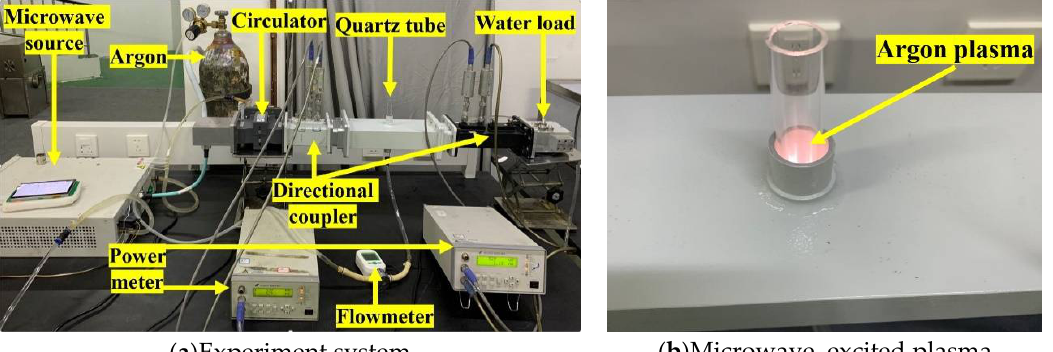
Figure 6. Measurement system.